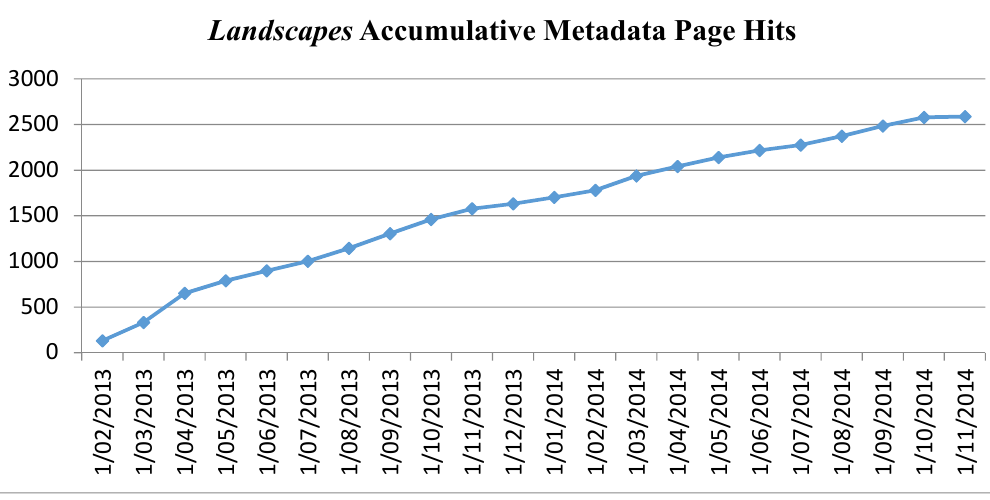
Figure 2. Landscapes Total Accumulative Downloads.